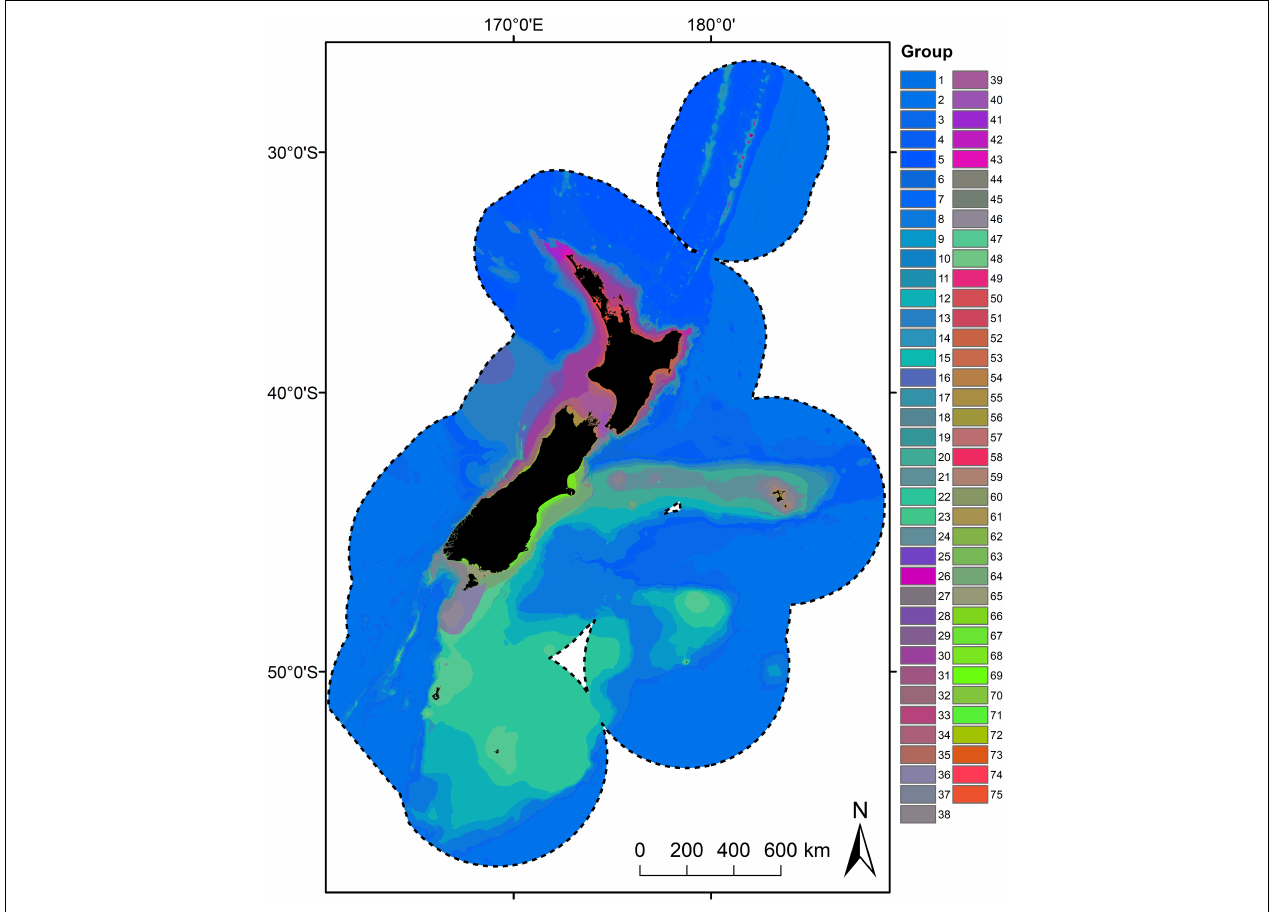
FIGURE 5 | Geographic distribution of the Seafloor Community Classification (75 groups) derived from combined bootstrapped Gradient Forest model. Colours are based on the first three axes of the PCA analysis applied to the group means for each of the transformed predictor variables, so that similarities/differences in colour correspond broadly to similarities/differences in predicted compositional